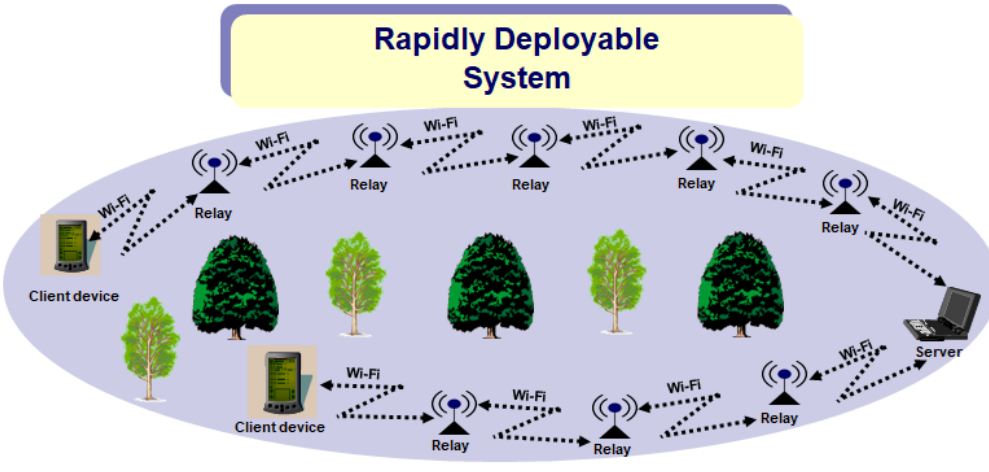
Figure 1. Deployment scenario of the RDSP